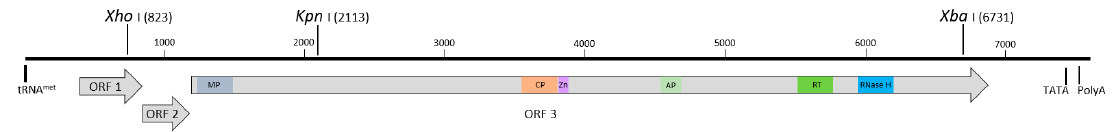
Figure 1. Linearized schematic representation of the genome organization of the BSCAV-Brisbane complete genome sequence. Block arrows represent the three open reading frames (ORFs) predicted from sequence analysis. Conserved protein motifs present in ORF 3 are indicated in color including the movement protein (MP, dark grey), coat protein (CP, orange), zinc finger domain (Zn, purple), aspartate proteinase (AP, light green), reverse transcriptase (RT, dark green) and ribonuclease H (blue). Additional genomic features highlighted include the conserved transfer RNA methionine (tRNA met ) complementary sequence denoting the start of the viral genome, and the putative TATA and polyA sequences predicted from sequence analysis. The location of the three unique restriction sites Xho I, Kpn I and Xba I used for construction of the infectious clone is also shown.